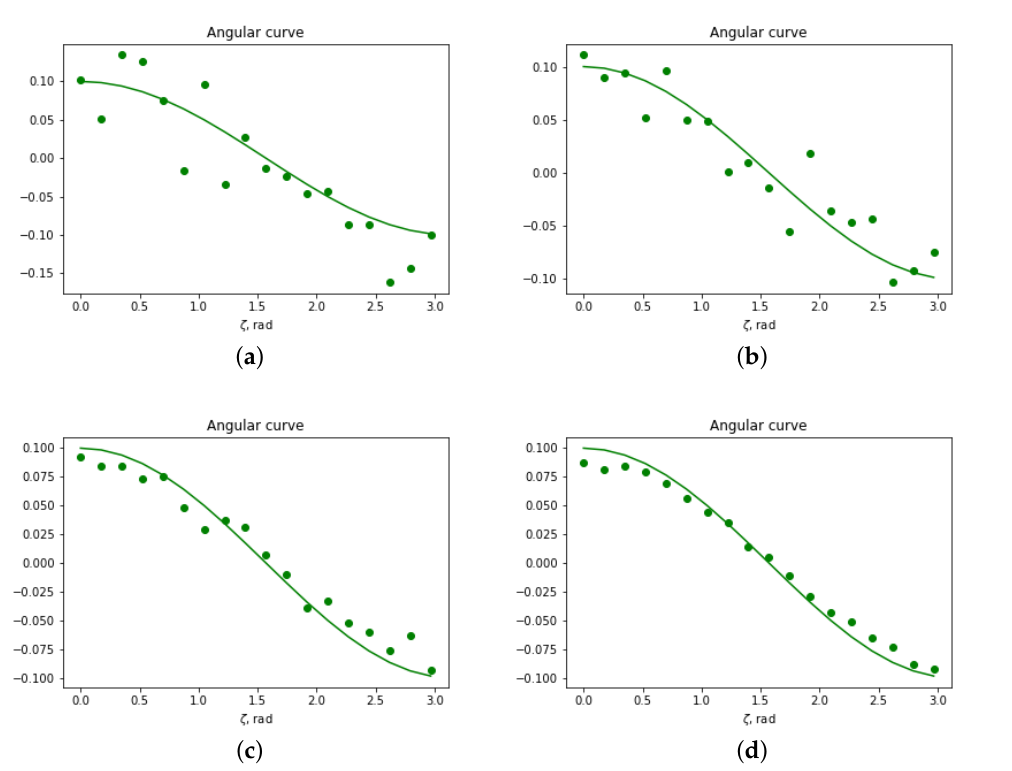
Figure 6. Angular curves for long-wavelength regime and weak noise. ( a ) T = 100 s; ( b ) T = 200 s; ( c ) T = 1000 s; ( d ) T = 10,000 s. The solid line corresponds to the analytic result without detector